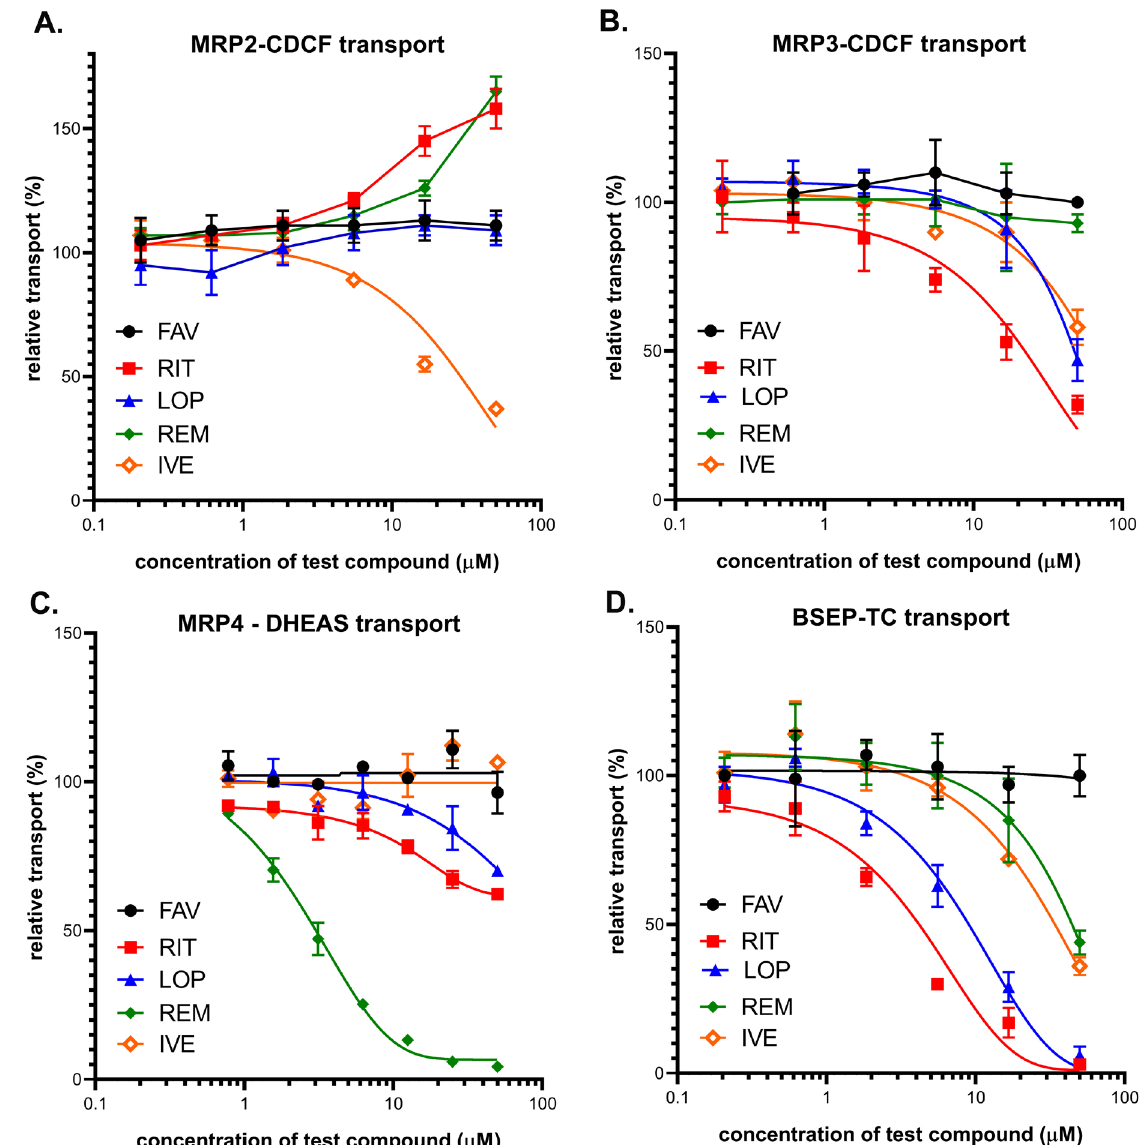
Figure 2. Inhibition of vesicular uptake of transporter-specific substrates by FAV, RIT, LOP, REM and IVE. ( A ) Inhibition of ATP-dependent vesicular uptake of CDCF in Sf9 cell membrane vesicles overexpressing MRP2. 30 µg (protein content) membrane vesicle was incubated with 5 µM CDCF at 37 °C for 10 min. Average values of 3 independent experiments +/− SE are shown. ( B ) Inhibition of ATP- and benzbromarone sensitive CDCF uptake into inverted HEK cell membrane vesicles overexpressing MRP3. 30 µg membrane vesicle was incubated with 5 µM CDCF at 37 °C for 10 min. Average values of 3 independent experiments +/− SE are shown. ( C ) Inhibition of ATP- dependent DHEAS uptake into inverted HEK cell membrane vesicles overexpressing MRP4. 50 µg membrane vesicle was incubated with 0.5 μM DHEAS at 32 °C for 1.5 min. Average values of 3 independent experiments +/− SE are shown. ( D ) Inhibition of ATP- and glyburide-sensitive taurocholate (TC) uptake into inverted HEK cell membrane vesicles, overexpressing BSEP. 50 µg membrane vesicle was incubated with 2 µM TC at 37 °C for 10 min. Average values of 3 independent experiments +/− SE are